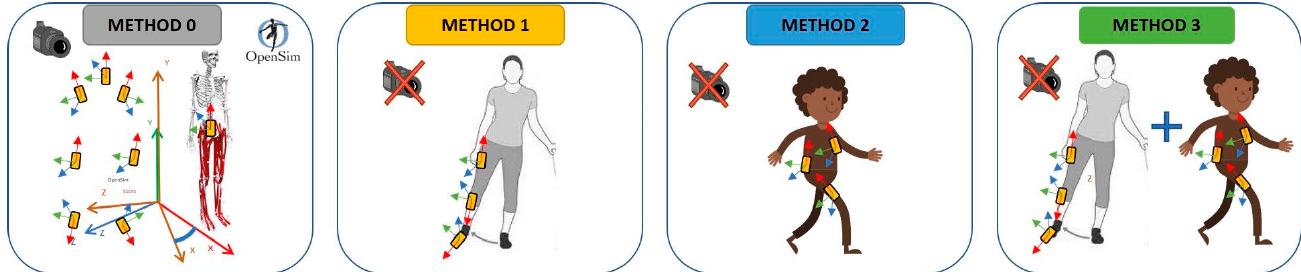
Figure 1. Method 0: One sensor (e.g., pelvis) aligned with the MSK model (MoCap derived pose) and with all the other sensors—static calibration approach [46]; Method 1: hip abduction–adduction motion to align thigh-shank-foot sensors—functional calibration [34]; Method 2: PCA-method based on sit-to-stand and walking to align torso-pelvis-thigh sensors—functional calibration [46]; Method 3: combination of Methods 1 and 2 for the alignment of all sensors—functional calibration [34,46].